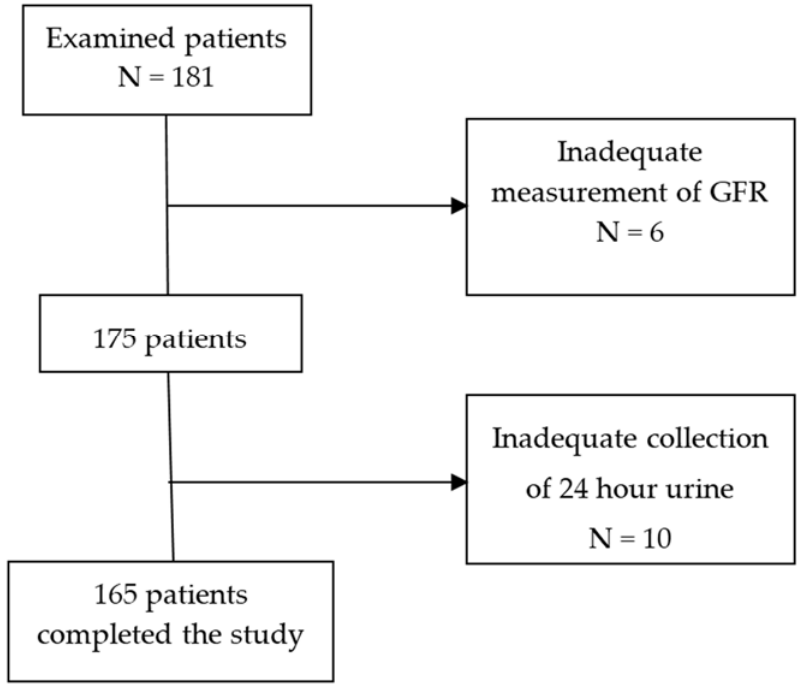
Figure 1. Flow diagram of the examined patients. GFR= glomerular filtration rate.